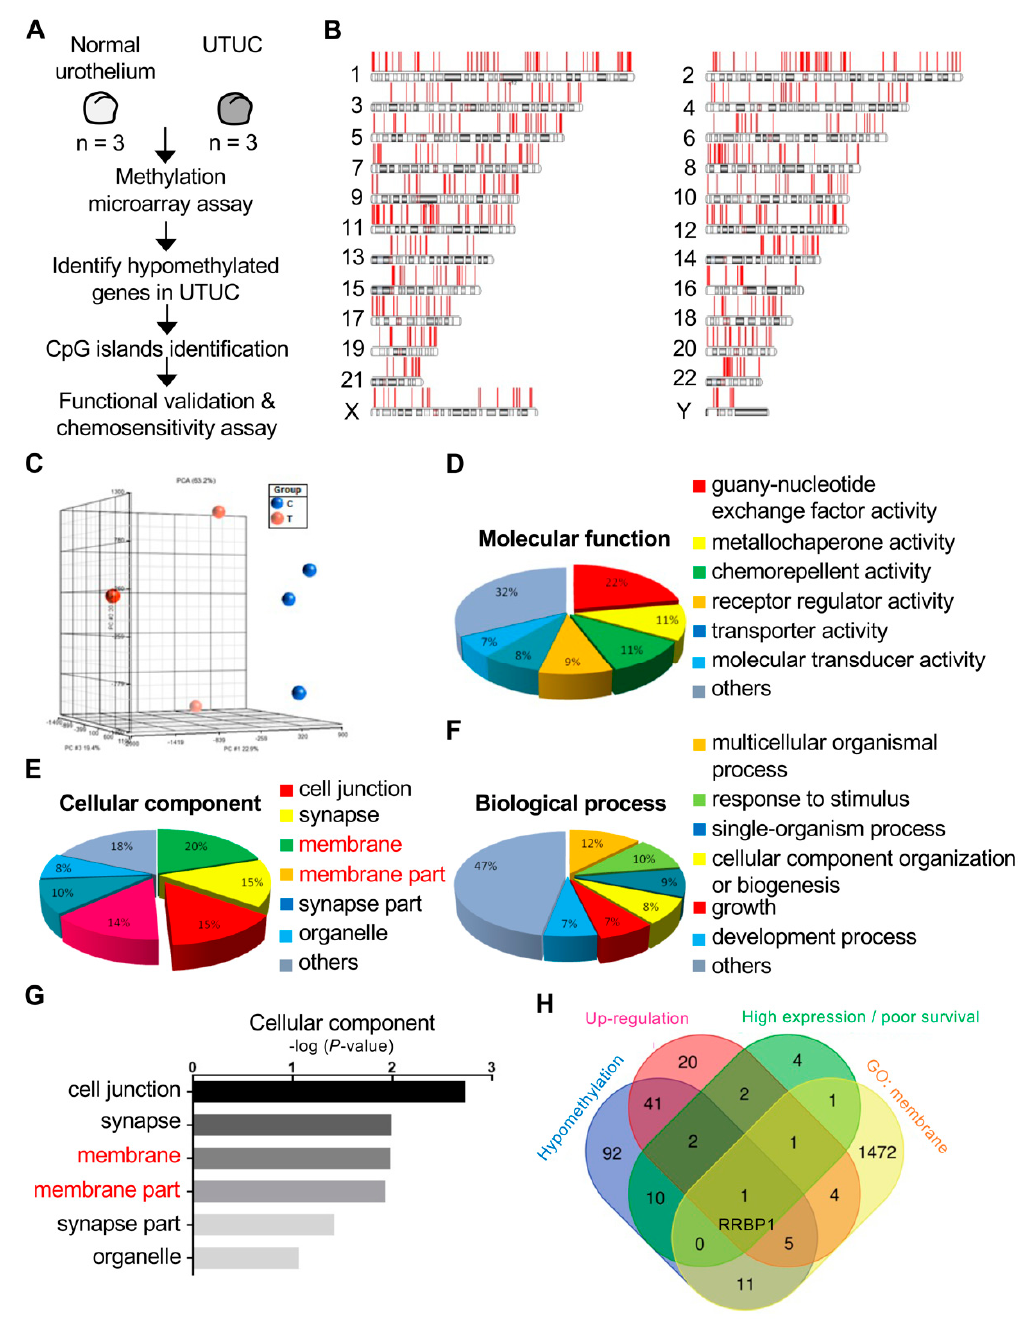
Figure 1. Methylation profiling analysis identified RRBP1 as an oncogene in UTUC. ( A , B ) The diagram shows the process of analyzing the DNA methylation profiles of normal and UTUC tumors. The DNA methylation was determined in UTUC tumor tissues from high-stage/high-grade patients and morphologically normal adjacent tissues (NAT) from low-stage/low-grade patients. The analysis of DNA methylation was conducted using a methyl-CpG binding-domain-based (MBD) protein microarray chip. ( C – F ) Gene oncology (GO) analysis of gene expression in molecular function, biological process, and cellular component. ( G ) Statistical analysis of gene expression in cellular component. ( H ) Venn diagram of RRBP1 satisfies the intersection conditions of hypomethylation, upregulated genes, poor survival, and cellular membrane component of GO analysis. Hypomethylation genes (133), upregulation genes (61), high expression with poor survival (5), and GO analysis: membrane (1473).